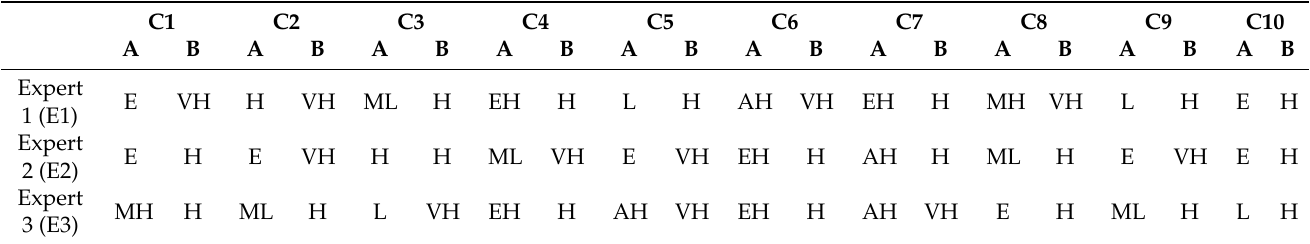
Table 3. Linguistic values when assessing the weight of criteria.